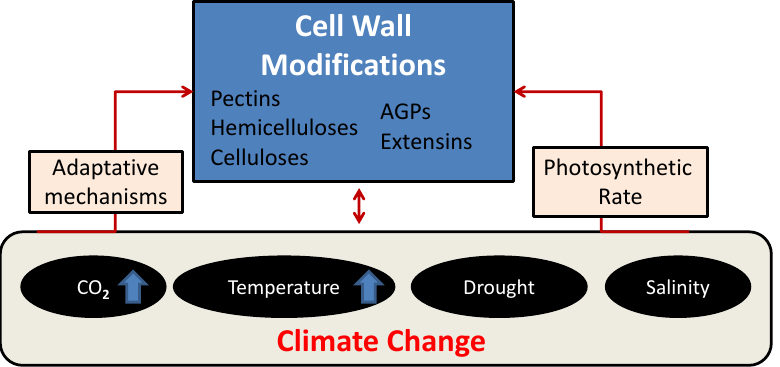
Figure 1. Diagram showing the interaction between climate change abiotic stress factors and plant cell wall (CW) responses. Climate change multifactorial abiotic stresses include drought, heat, salinity, and rise of atmospheric CO 2 . In addition, one of the consequences of rising CO 2 concentration is expected to be the increase of photosynthetic rate, especially at high temperatures and under water-limiting conditions. The e ff ects of global warming on CW homeostasis and adaptive mechanisms by CW reorganization to induce tolerance in crops are topics of discussion in this